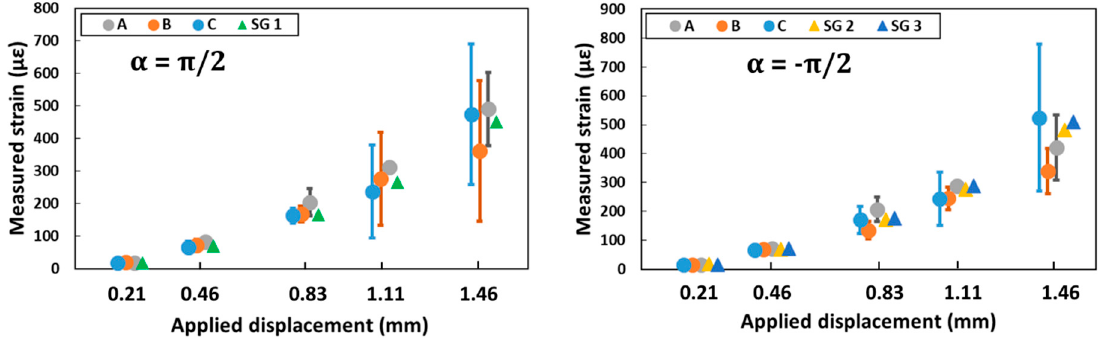
Figure 8. Time evolutions of the applied displacement and corresponding load during the compression test.